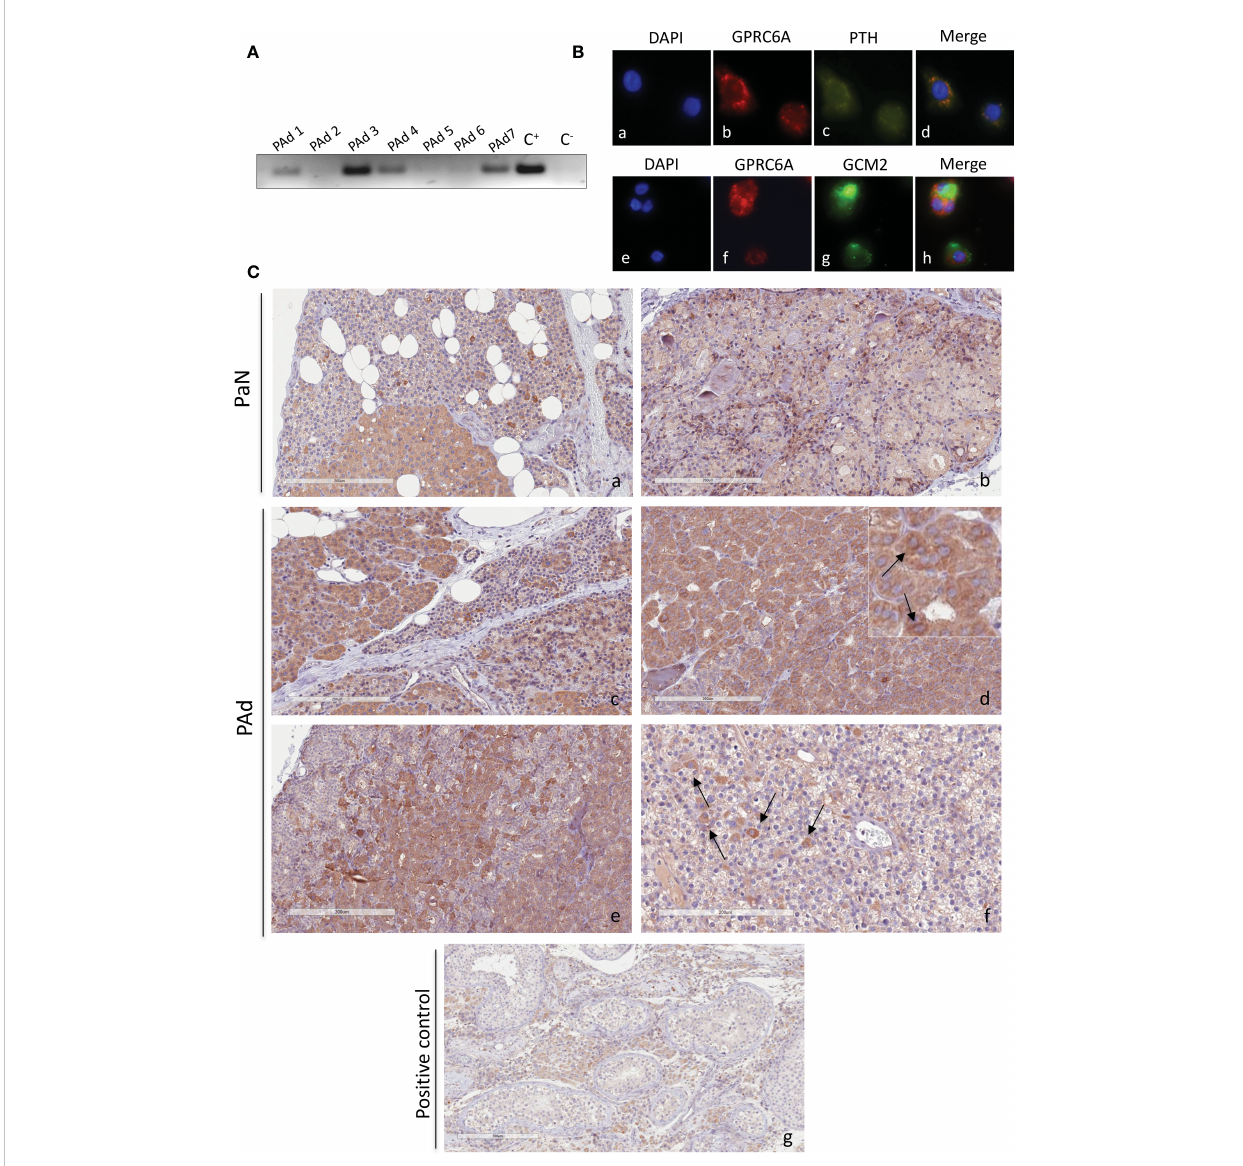
FIGURE 3 GPCR6A expression in human parathyroid cells. (A) GPRC6A transcripts were variably detected by RT-PCR in total RNA from PAds (n=7) of PHPT patients; C + , plasmid encoding GPRC6A; C - , water. (B) Immuno fl uorescence of short-term cultured PAds-derived cells showed cytoplasmic and membrane expression of GPRC6A (red, b, f ); PTH (green, c ) co-expressed with GPRC6A (merge, d ) GCM2 (green, g ) co-expressed with GPRC6A (merge, h ). (C) Immunohistochemistry by a speci fi c anti-GPRC6A antibody in normal parathyroid glands from normocalcemic patients with thyroid diseases (a, b) and in parathyroid adenomas (panels c – f ). (g) Human testis with GPRC6A-expressing Leydig cells were used as positive control. Insert in (d) shows cells with GPRC6A expression at membrane level. Magni fi cation 20X; bars, 200 m